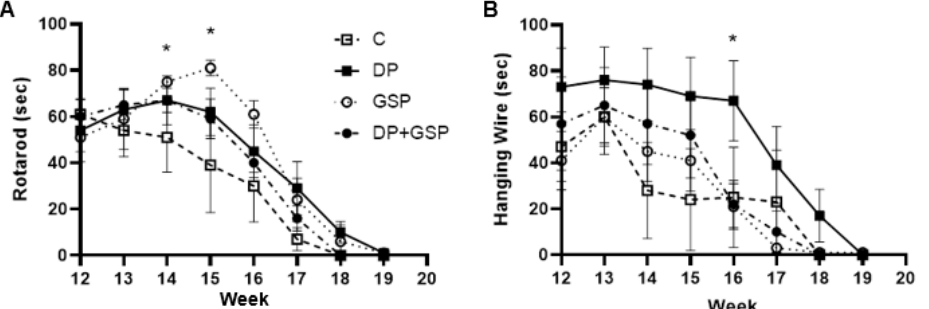
Figure 6. Effect of treatment on motor function. Graphs depicting average time for each group for each week are shown. Data points indicate mean +/ − SEM. After one week of training and familiarization with the accelerating rotarod and the hanging wire test, mice were tested once per week on each apparatus. ( A ) Rotarod test for endurance and coordination. Compared to baseline, C mice showed a steady decline in performance beginning at week 13, reaching significance at week 17 ( p = 0.001). DP mice showed slight statistically insignificant improvement at week 14 before decline began, which reached significance at week 18 ( p = 0.004). GSP mice showed a significant improvement at weeks 14 and 15 before decline began, reaching significance at week 18 ( p = 0.006). GSP mice performed significantly longer than C at week 14 and 15, indicated by asterisk ( p < 0.05). DP+GSP mice remained relatively level up to week 15 before decline began, which reached significance at week 16 ( p < 0.05). ( B ) Hanging wire test for strength. Compared to baseline, C mice showed a decreased performance by week 14. DP mice remained consistent until week 17 and were significantly higher at week 16 than C ( p = 0.045). DP mice performed significantly longer than C at week 16, indicated by symbol ( p < 0.05). GSP mice remained relatively stable up until week 16. DP+GSP mice remained relatively stable up until week